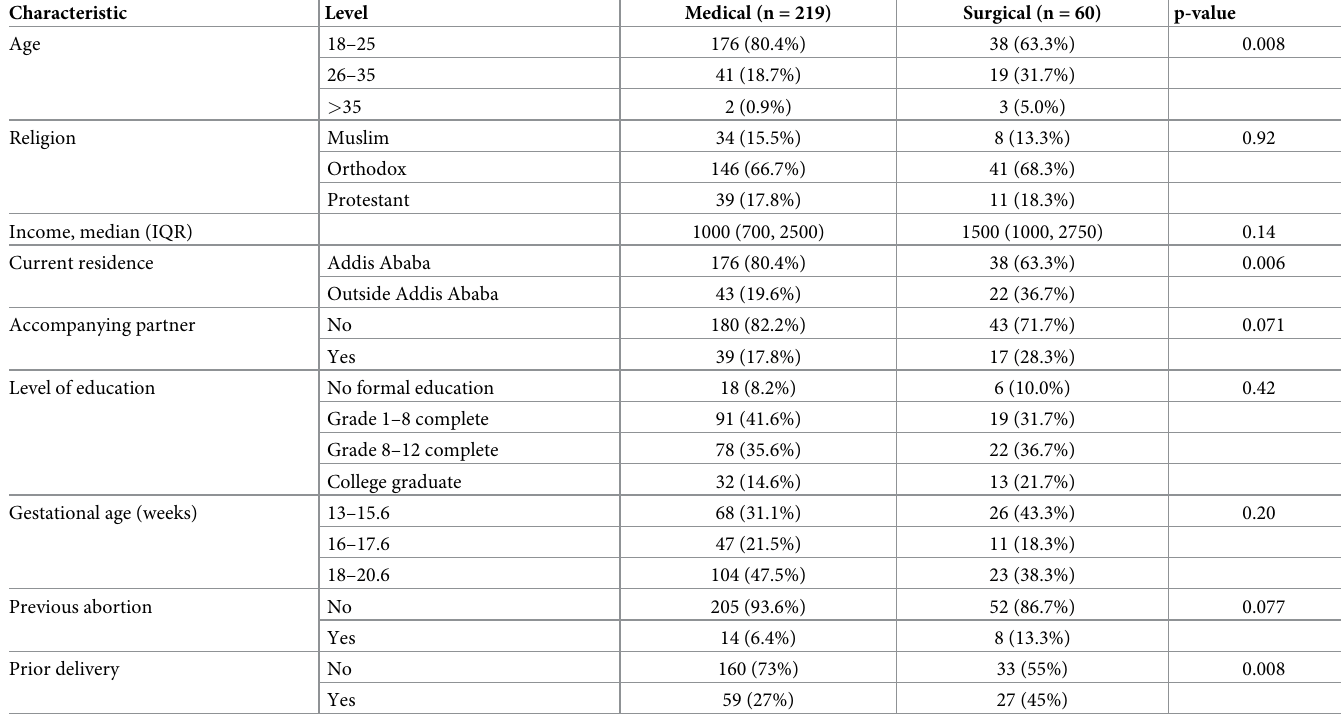
one. In addition to the mifepristone, surgical patients either received laminaria only (13.3%), misoprostol only (56.7%), or both laminaria and misoprostol (30.0%) for cervical priming prior to dilation and evacuation. Table 1. Baseline characteristics of study